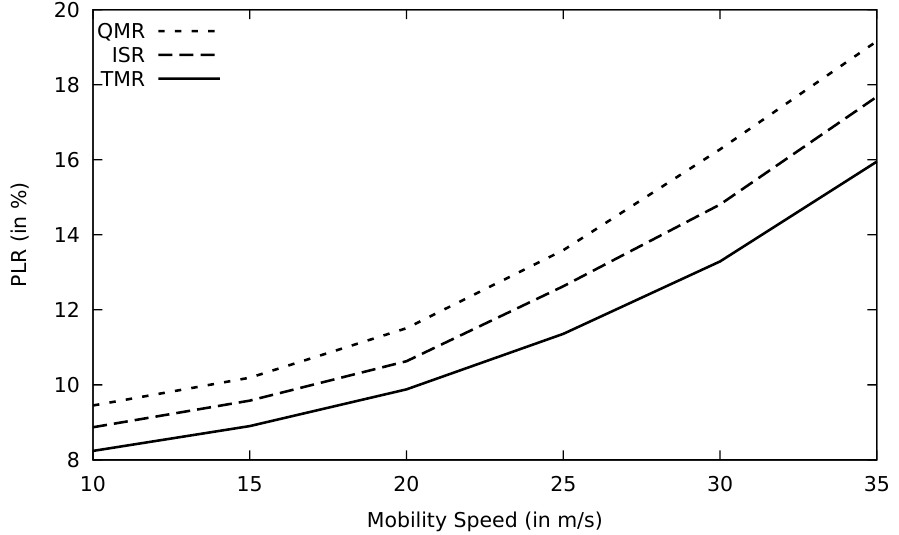
Figure 29. Comparison of QMR, ISR, and proposed protocol TMR for PLR with mobility speed. The average end-to-end delay increases when mobility speed increases due to link failure and retransmission of data. The given justification is proven in Figure 30. As the result of the route selection mechanism based on the minimum RTT in TMR, the lowest end-to-end delay emerged for TMR, followed by ISR and QMR. Table 6 indicates that TMR saves end-to-end delay by 26.1 and 11.7 percent compared to QMR and ISR, respectively. According to Equation (4), the routing overhead is the result of two parameters: data and routing packets. Therefore, when the PLR increases, the number of successfully delivered data packets drops. Therefore, the routing overhead ratio increases. Additionally, the routing protocol has to go through the routing discovery phase in case of link failure, which produces more routing packets. The TMR has the lowest routing overhead in Figure 31, which proves the throughput and PLR result. With increasing mobility speed, the ISR and QMR routing overhead is distinguishable from